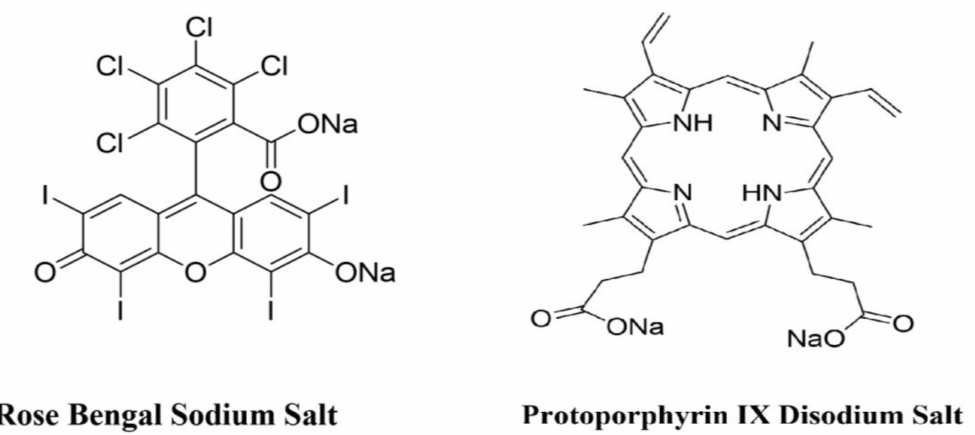
Figure 6. Structural formulas of photosensitizers (Rose Bengal Sodium Salt and Protoporohyrin IX Disodium